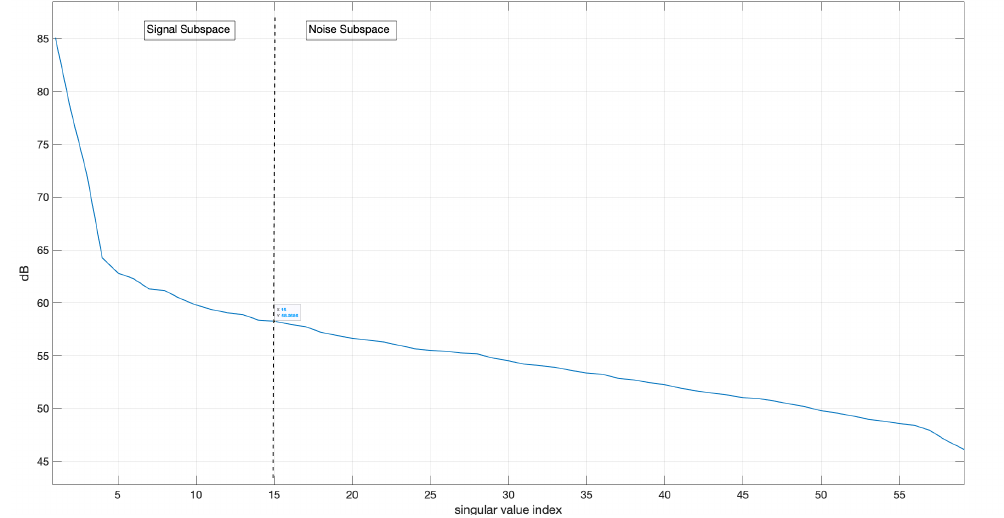
Figure 4. Singular values of a generic